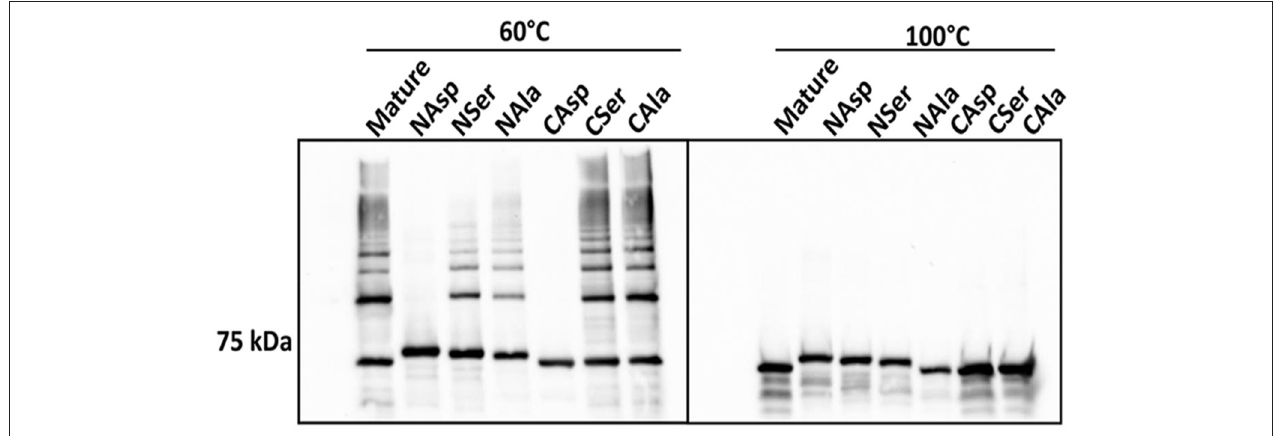
FIGURE 7 | Mfa1 polymerization is prevented by substitutions in hydrophobic domains. Mature Mfa1 protein or derivatives with N-terminal or C-terminal substitutions were heated separately to 60 ◦ or 100 ◦ C prior to SDS-PAGE, and immunoblotting with antibodies to Mfa1. N-terminal (N) or C-terminal (C) aspartic acid, serine, or alanine substituted derivatives are indicated. Results are representative of 3 biological replicates.